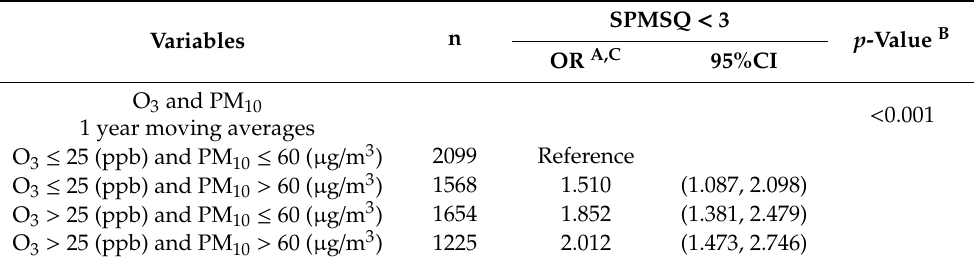
Table 3. Combined e ff ects of long-term exposure to O 3 and PM 10 on moderate-to-severe cognitive impairment (n =